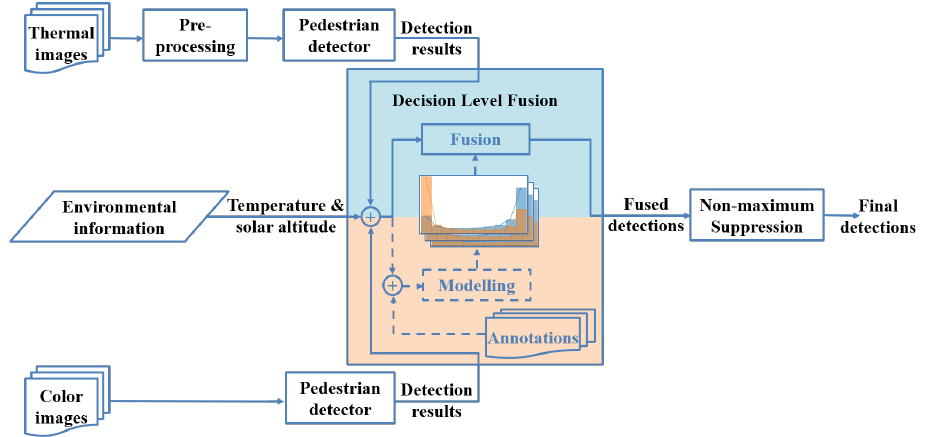
Figure 1. Proposed